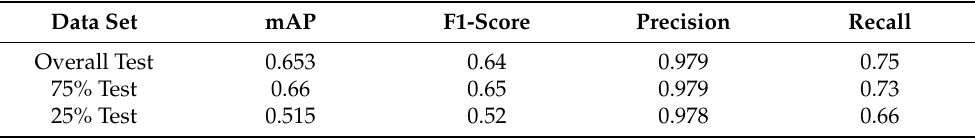
Table 4. Performance metrics of the final model after inference over the entire test data set, the data containing the bounding boxes with the lowest 25% percentage coverage and the data set containing the bounding boxes with the highest 75% percentage coverage within the test data set. Table 2 presents the mean average precision, f1-score, precision and recall of each model. Data Set mAP F1-Score Precision Recall Overall Test 0.653 0.64 0.979 0.75 75% Test 0.66 0.65 0.979 0.73 25% Test 0.515 0.52 0.978